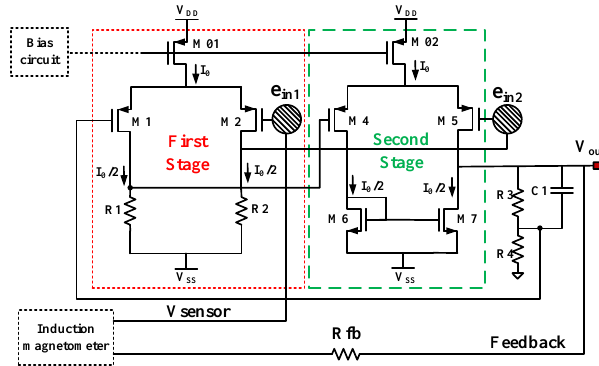
Figure 2. Schematic of the ASIC amplifier